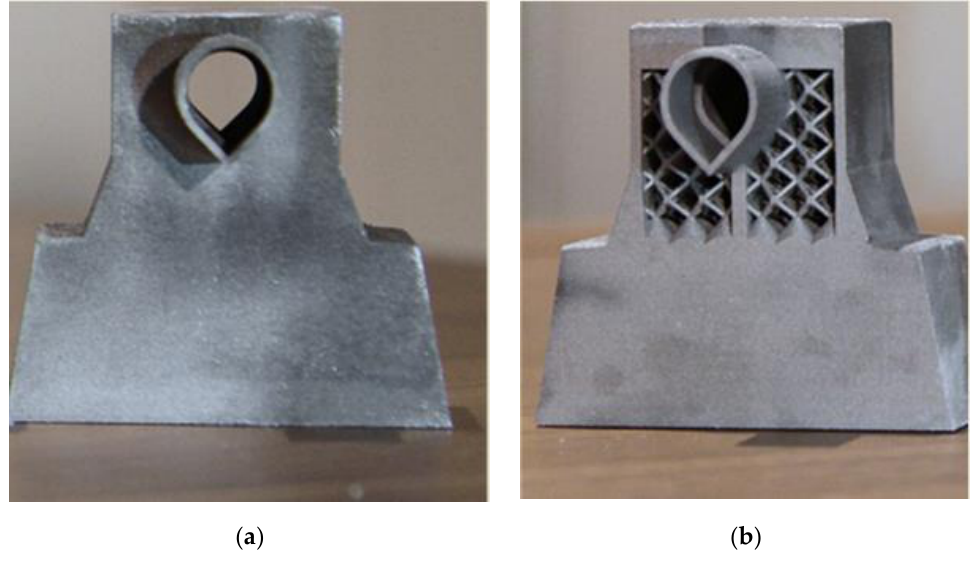
Figure 3. Printed demonstrators: ( a ) solid die; ( b ) proposed die. Table 1. SLM build parameters.